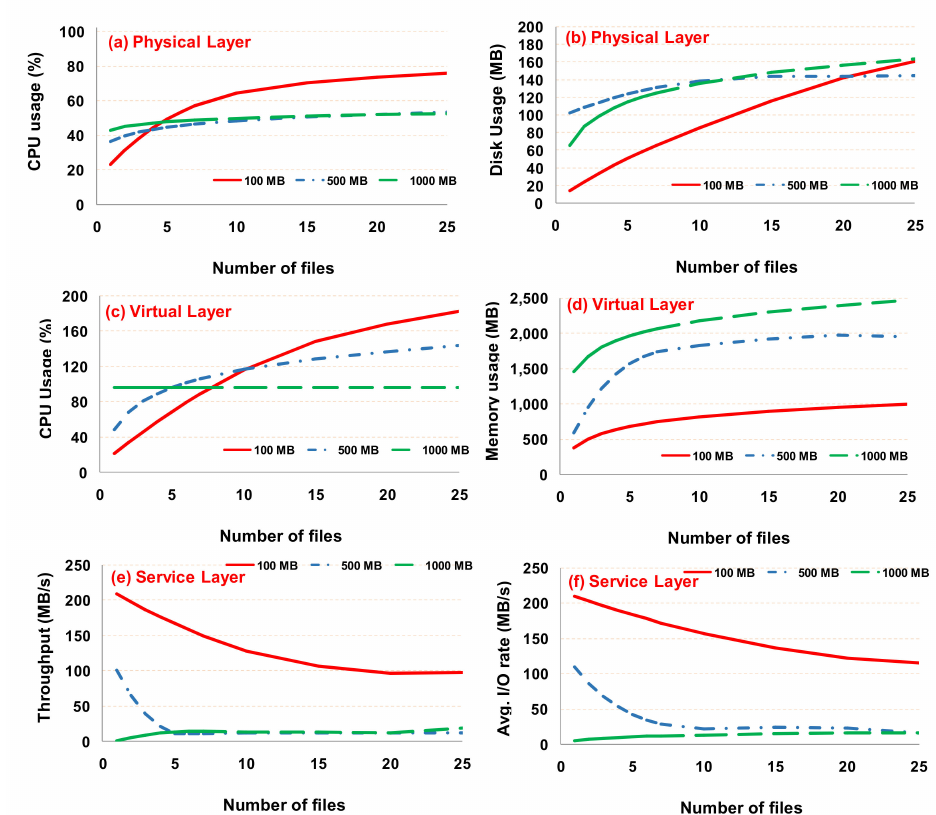
Figure 3. Critical system metrics monitored from three layers. ( a , b ) physical layer metrics, ( c , d ) vir- tual layer metrics, ( e , f ) service layer metrics.